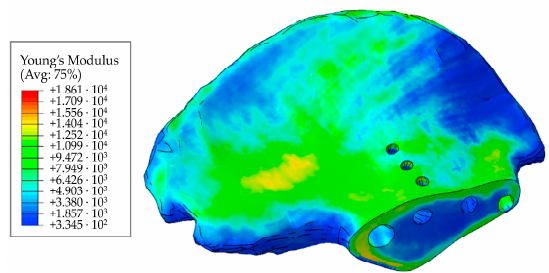
Figure 16. Distribution of elastic moduli in the pelvic bone, MPa.